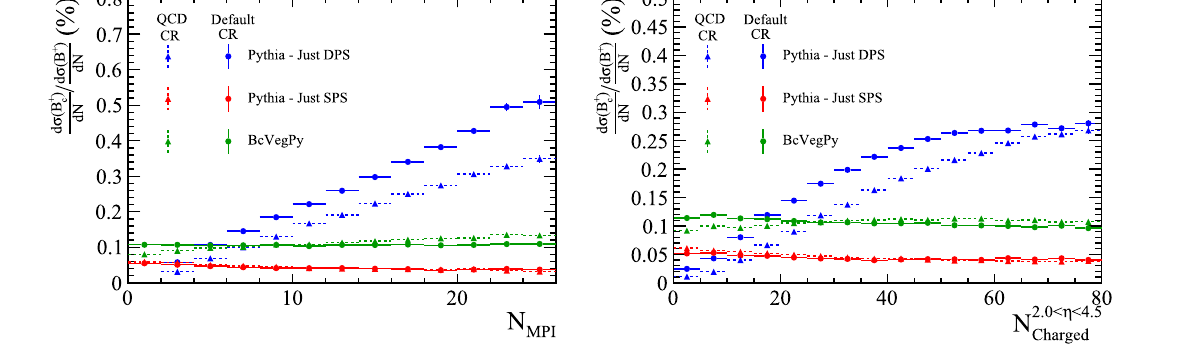
2 . 0 < η < 4 . 5, as generated with Pythia both with the alternative CR options specified in Table 4 (triangles) and with the default CR options (circles)